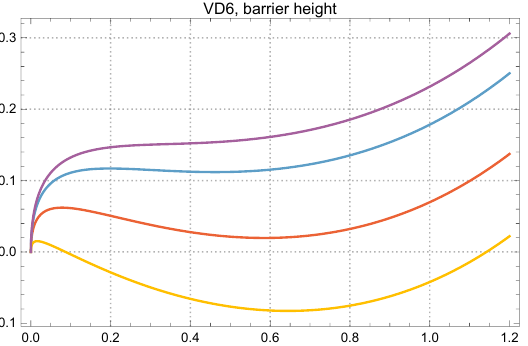
Figure 9 . Plot of the potential profiles as a function of u for various probes on purely electric black holes with r = 1 / 8 , f = 1 and temperature T = 0 . 045 , 0 . 17 , 0 . 28 , 0 . 33 (yellow, red, blue, violet H respectively). One can see that the probes closer to the horizon have a higher value of the minima of the potential (“barrier height”) with respect to those lying further